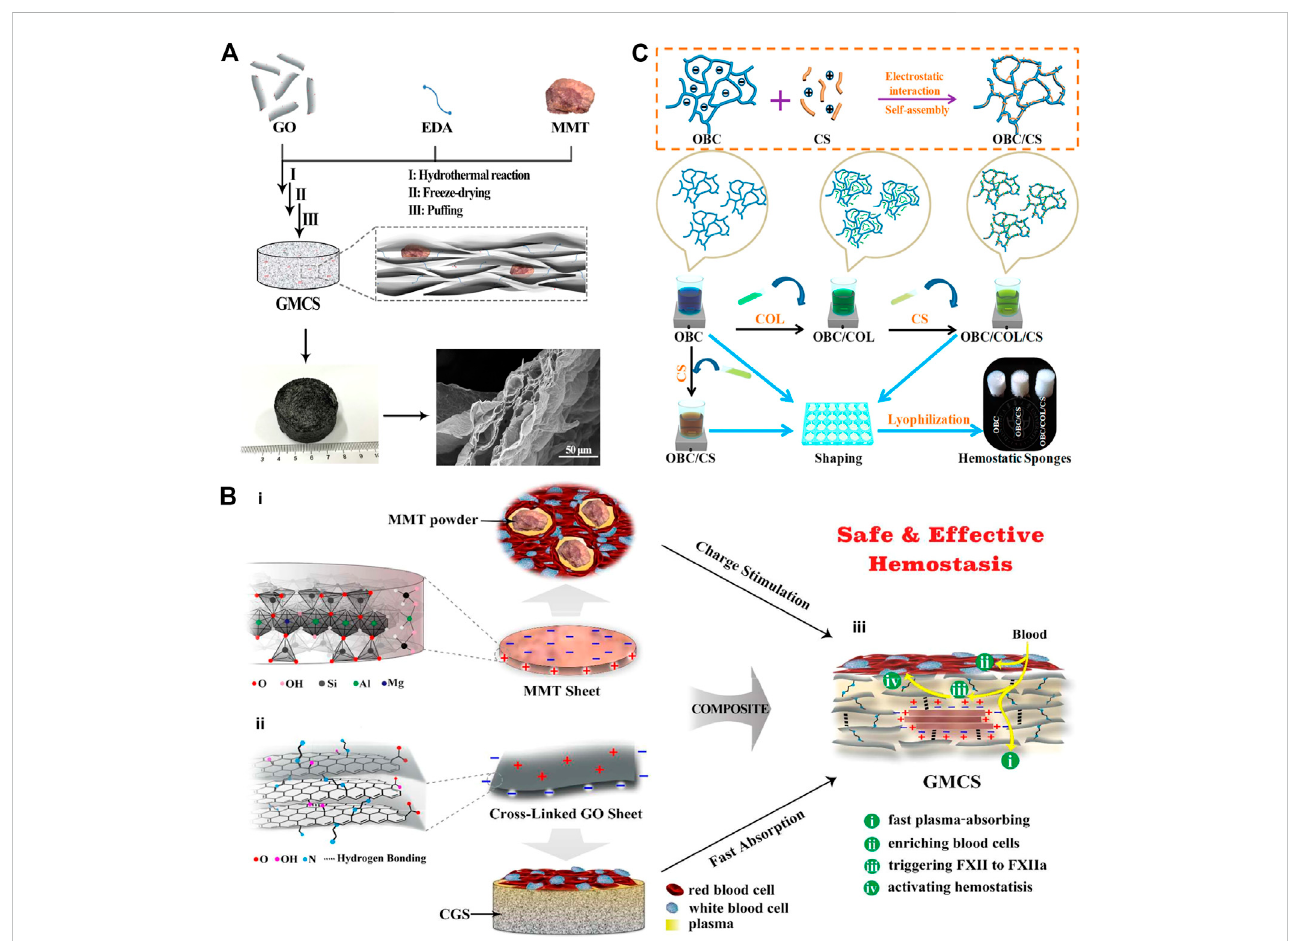
FIGURE 2 Naturallyderivedbiomaterialsareappliedinhemostasis. (A) Schematic representationofthepreparationrouteandthemicrostructureoftheGMCS.The GMCS is fi rstly synthesized by hydrothermal reaction employing GO sheets, EDA linkers and MMT powders. Then, after freeze-drying and puf fi ng treatments, the fi nal product is obtained. The enlarged microstructure image shows MMT is fi xed into the layered graphene. (B) Schematic representation of the GMCS construction and the potential synergy effect for hemostasis. (i) The MMT sheet possesses a permanent negative surface charge and a positive edge arisingfromtheorderedanddisorderedcrystalstructure,respectively.Theirpowderscanstimulate insitu clottingofbloodwithinwardhydrationandoutward activating of blood coagulation. (ii) The cross-linked graphene sheet possesses a positive surface charge arising from EDA linkers and a permanent negative edgechargefrominherentcarboxylgroups.TheresultedCGScanabsorbplasmarapidly,increasingtheconcentrationofhemocytesandplatelets.(iii)MMTis fi xed in the GMCS by the rich interactions, such as hydrogen bonding and electrostatic interactions. Reproduced from (Li et al., 2016) with permission from Copyright 2016 American Chemical Society. (C) Schematic diagram of the synthesis of OBC, OBC/CS, and OBC/COL/CS hemostatic sponges. Reproduced from (Yuan et al., 2020) with permission from Copyright 2019 American Chemical